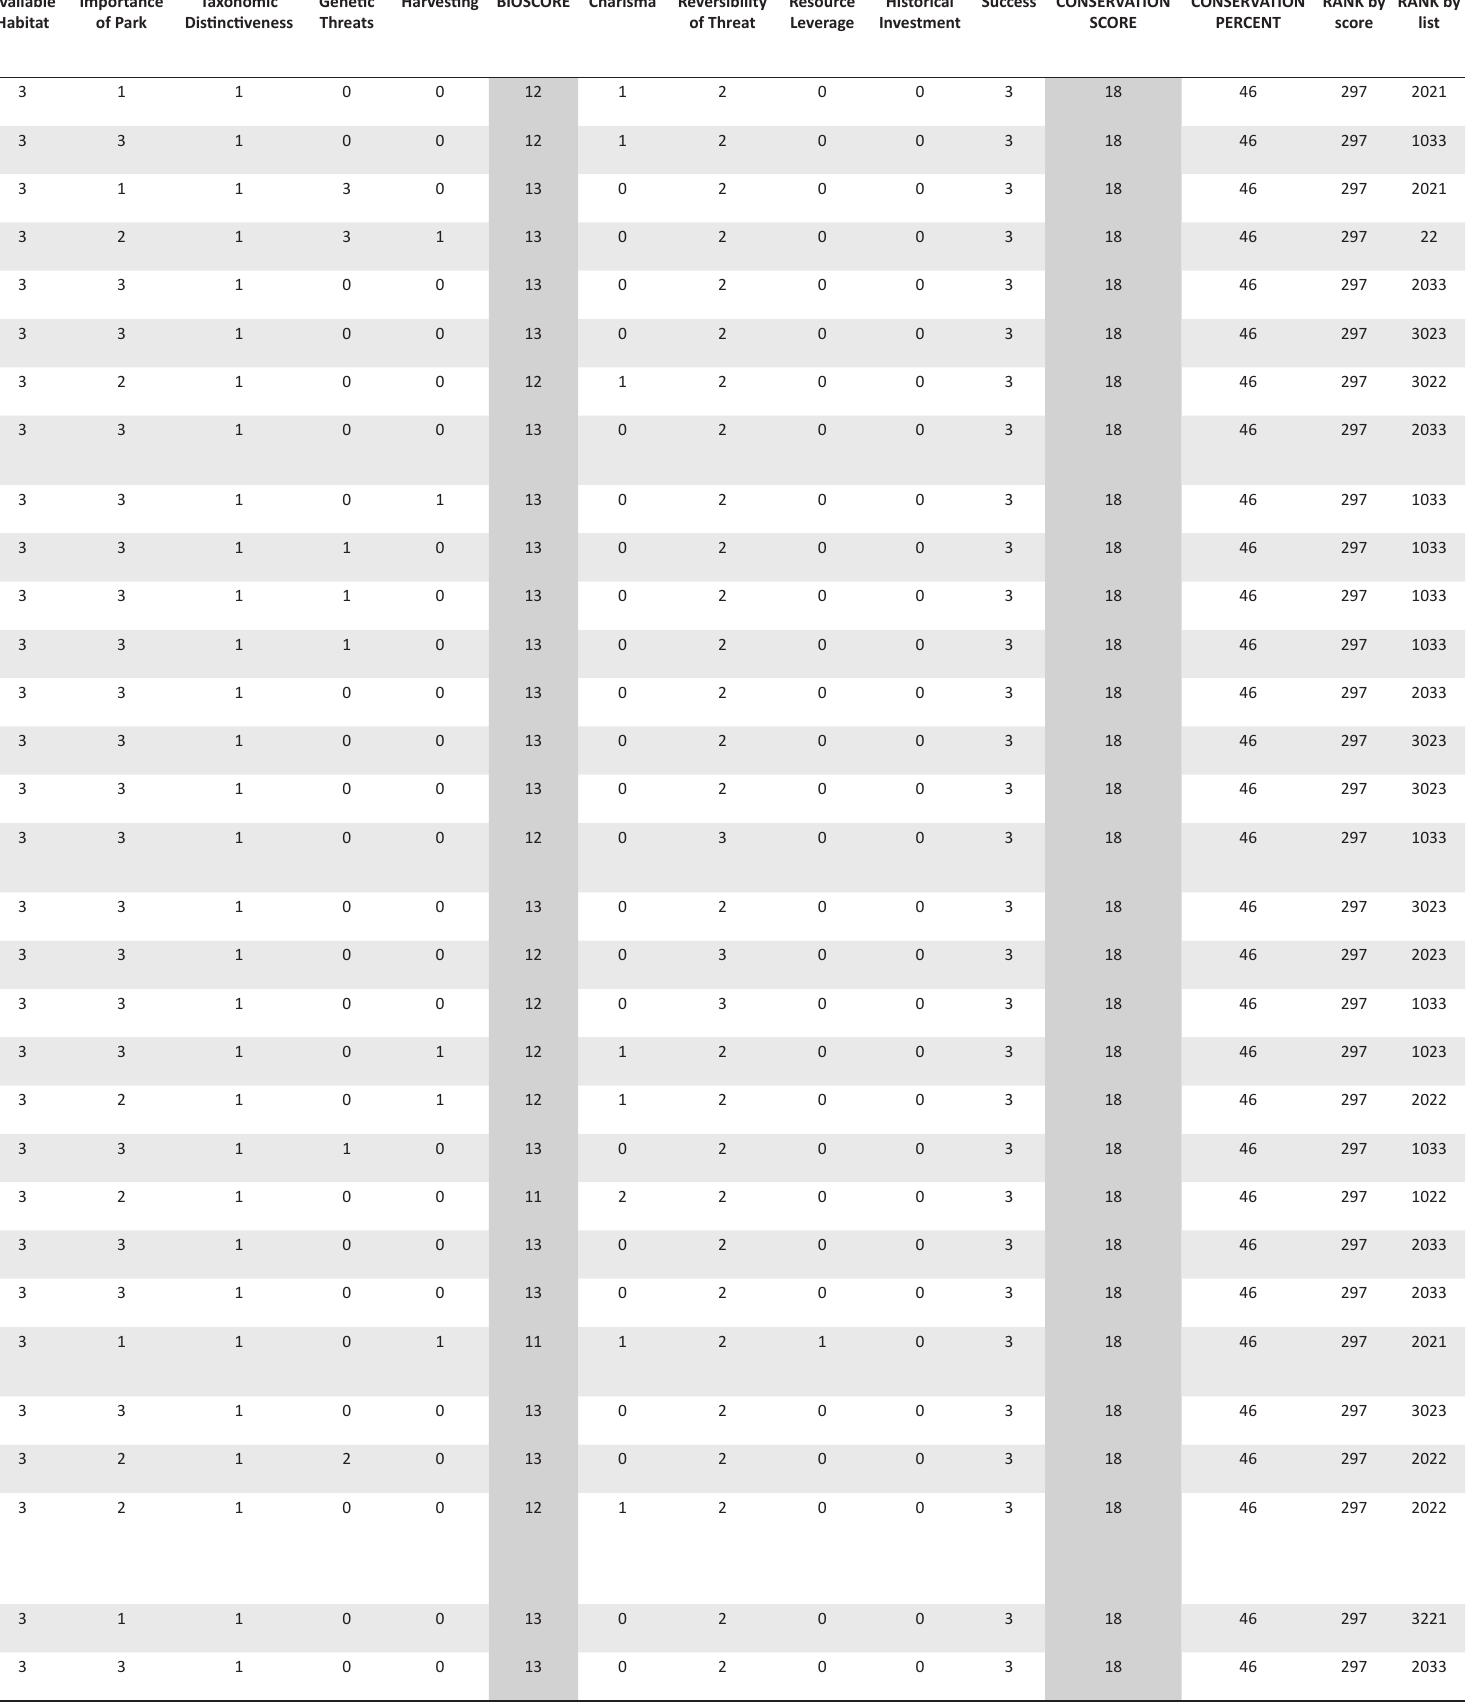
Pseudoselago peninsulae Peninsula Purplepuff Syncordalia venator Mahogany Presba Pentaschistis ecklonii Eckons Fivesplit Grass Passerina ericoides Ericoid Gannabos Leucospermum hypo- phyllocarpodendron subsp. hypophyllocar- podendron Green-snake- stem Pincushion Cotula filifolia Fine-leaf Button Roella decurrens Longbase